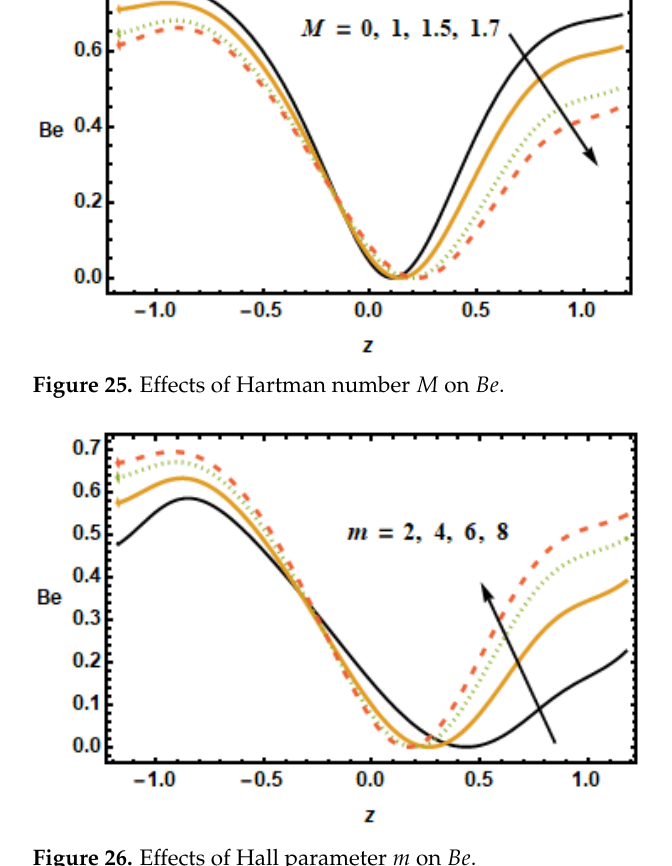
Figure 26. Effects of Hall parameter m on Be .